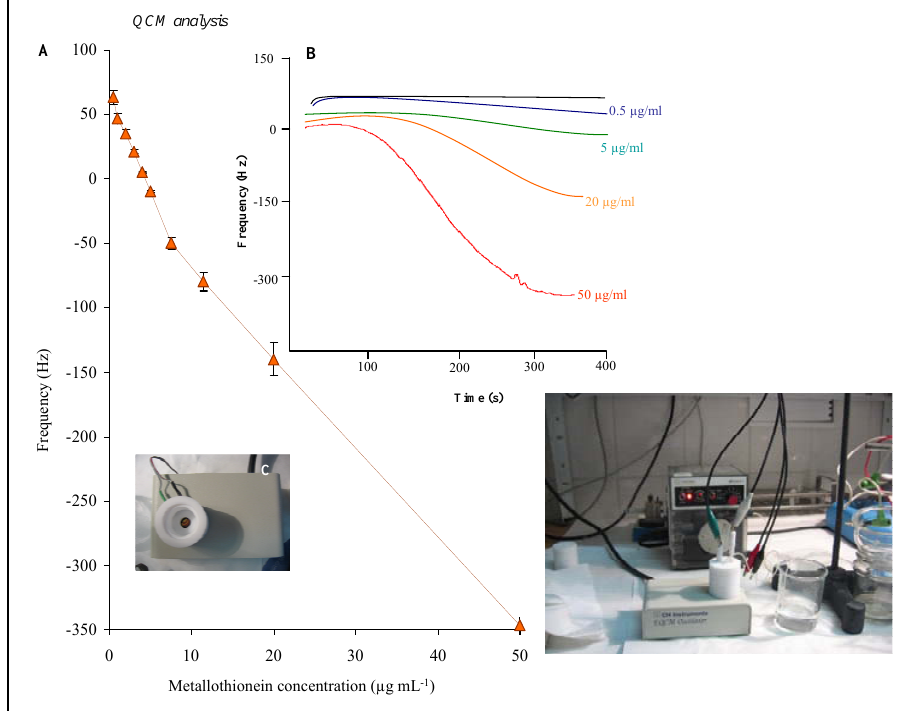
Figure 5. QCM analysis of MT on the gold crystal. (A) Dependence of the crystal frequency on MT concentration. (B) Typical QCM signals of frequency change after application of 0, 0.5, 5, 20 and 50 µg/mL MT. In inset: Photograph of experimental arrangement of QCM. Supporting electrolyte: 0.2 M phosphate buffer (pH 7.0), flow rate 1 mL min -1 for rinsing the crystal, n =